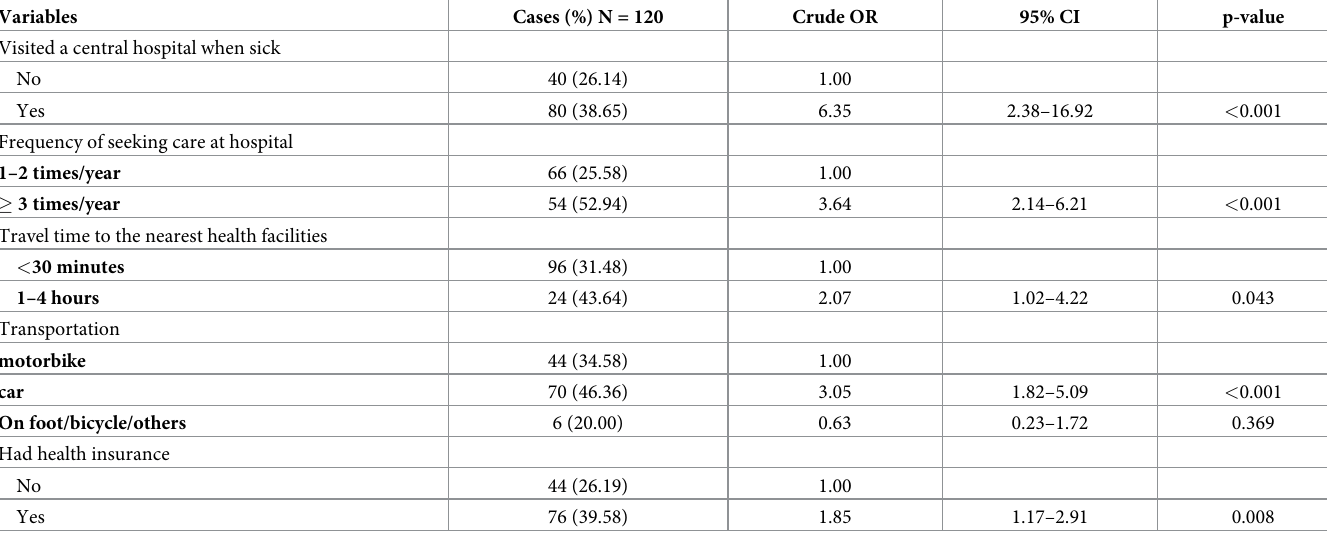
Table 3. Bivariate analyses of association between cervical cancer screening and participants’ accessibility to healthcare services.